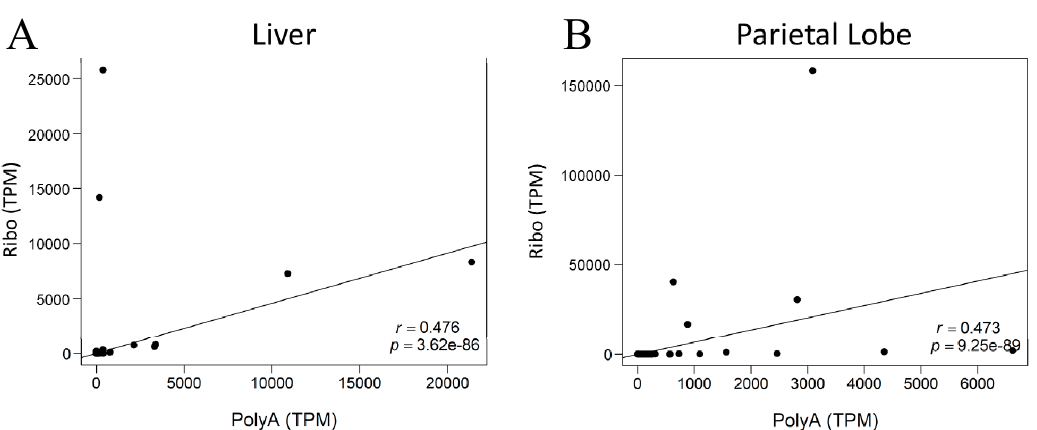
Figure 4. Correlation plots for lncRNA expression in AH1 with annotated transcripts. The x-axis indicates expression of the individual lncRNA in the poly-A + selected library. The y-axis shows expression of the same lncRNAs in the rRNA-depleted library. ( A ) Liver ( B ) Parietal lobe of the cerebrum. Spearman correlation (r) and p -value in bottom right corner.